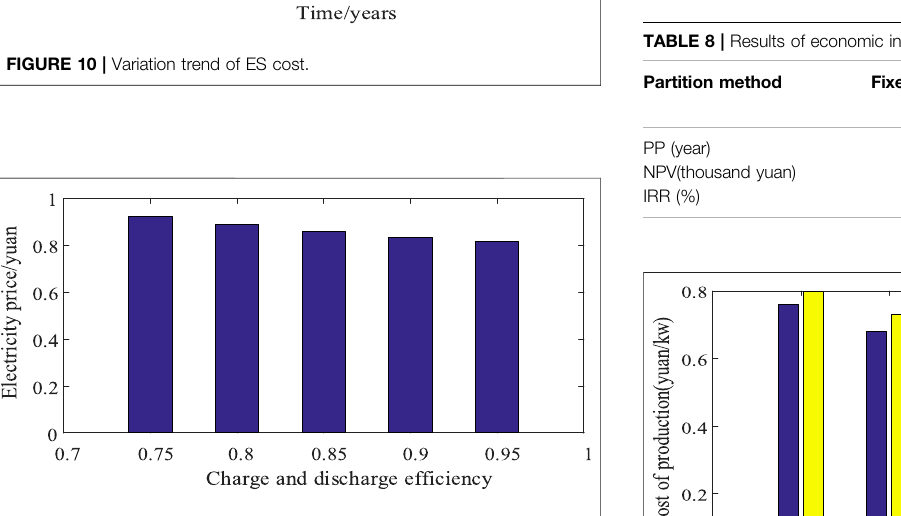
FIGURE 11 | Relationship between ES ef fi ciency and critical peak-valley price difference.